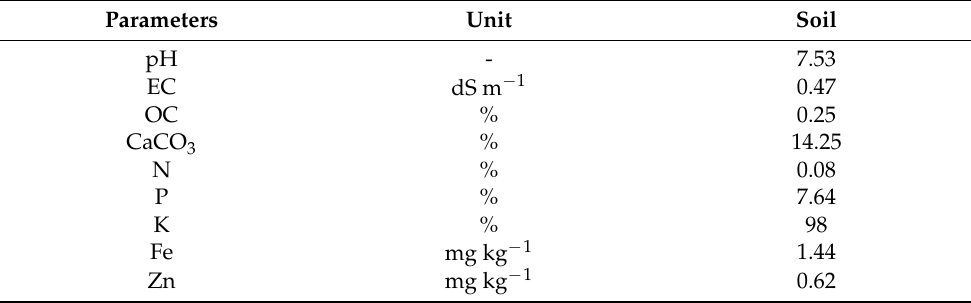
Table 1. Physicochemical properties of loamy sand soil.